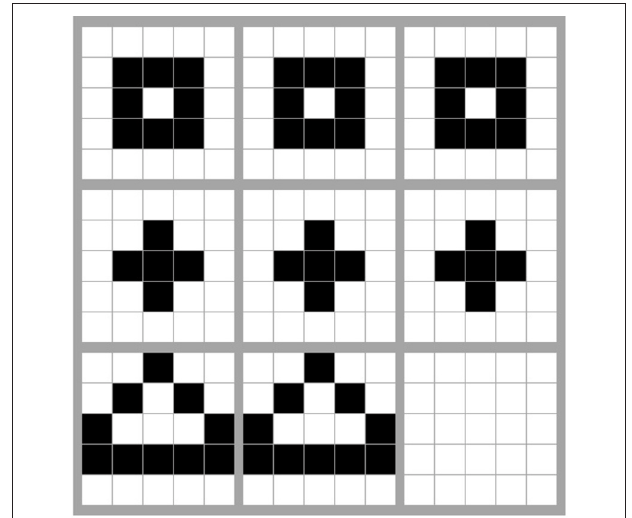
FIGURE 1 | Sample FRM item (Piskernik, 2013). The missing figure was constructed by clicking on the squares to turn them from white to black in the computerized version or coloring the squares with a marker in the paper-pencil version.